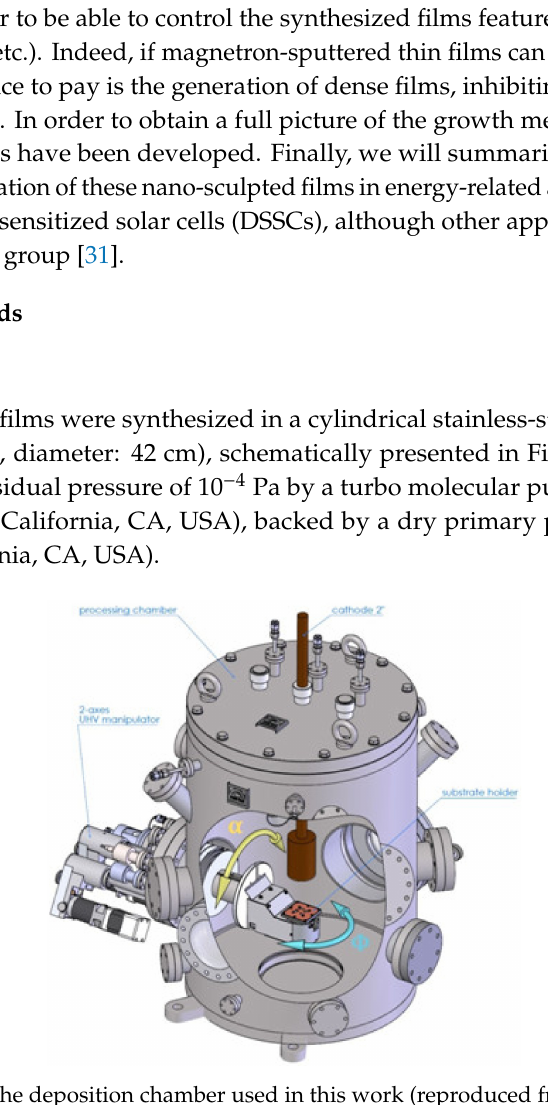
Figure 2. Sketch of the deposition chamber used in this work (reproduced from [32], MDPI, 2019). An unbalanced magnetron cathode was installed in front of the substrate, at the top of the chamber on which a 2 in. (5.08 cm) diameter and 0.25 in. (0.635 cm) thick target was connected. The target / substrate distance was fixed at 7 cm. Pure Ti and Mg (both with 99.99% purity) were used as target materials in this study. In order to modify the phase constitution of the deposited films, the target was sputtered either in direct current (DC) mode or in the high power impulse magnetron sputtering (HiPIMS) regime. For the DC mode, an Advanced Energy MDK 1.5 K (Advanced Energy, Denver, Colorado, CO, USA) power supply was used. The power (P) was fixed at 150 W, corresponding to a − 2 power density on the target surface of 7.5 W · cm , which was calculated by taking into account the target surface exposed to the plasma (~20 cm 2 ). In the HiPIMS regime, a lab-made power supply based on a one-quadrant chopper topology was used, allowing the generation of short high-power pulses at the cathode [33]. We have to mention that the discharge voltage is measured at the output of the lab-made power supply, not directly at the cathode. More information can be found elsewhere